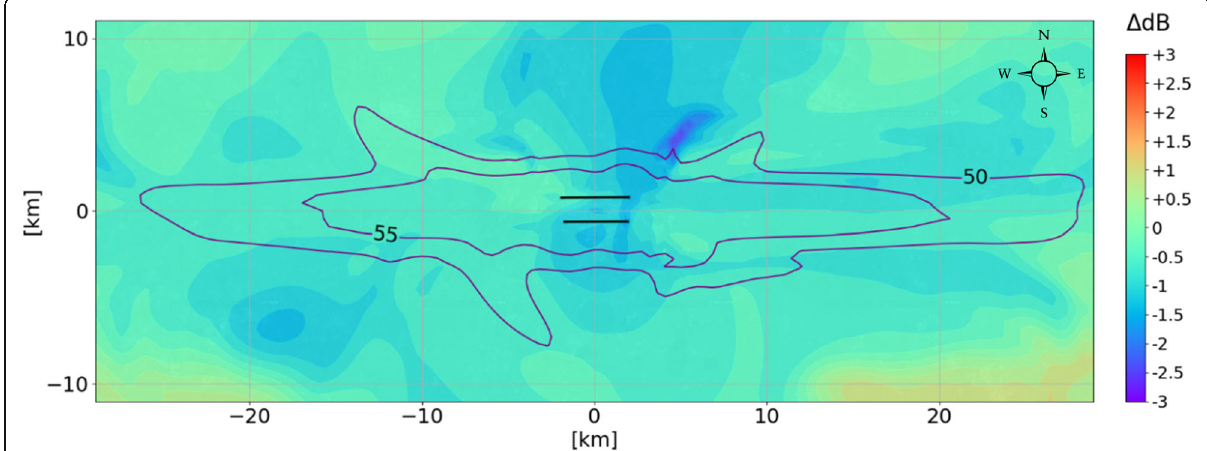
Fig. 4 Map of predicted variations in L DEN at Heathrow Airport from 2018 to 2025 due to fleet substitution ( Δ dB = L DEN,2025 – L DEN,2018 ). 50-dB and 55-dB L DEN contour lines computed for 2018 are